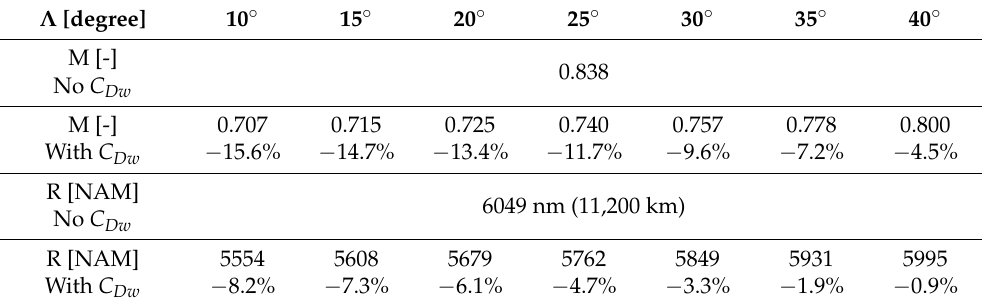
Figure 12. Drag breakdown of a fictitious T-category airplane as a function of sweep angle Λ . Table 6. Maximum range and best cruise airspeed for both models, with and without wave drag.